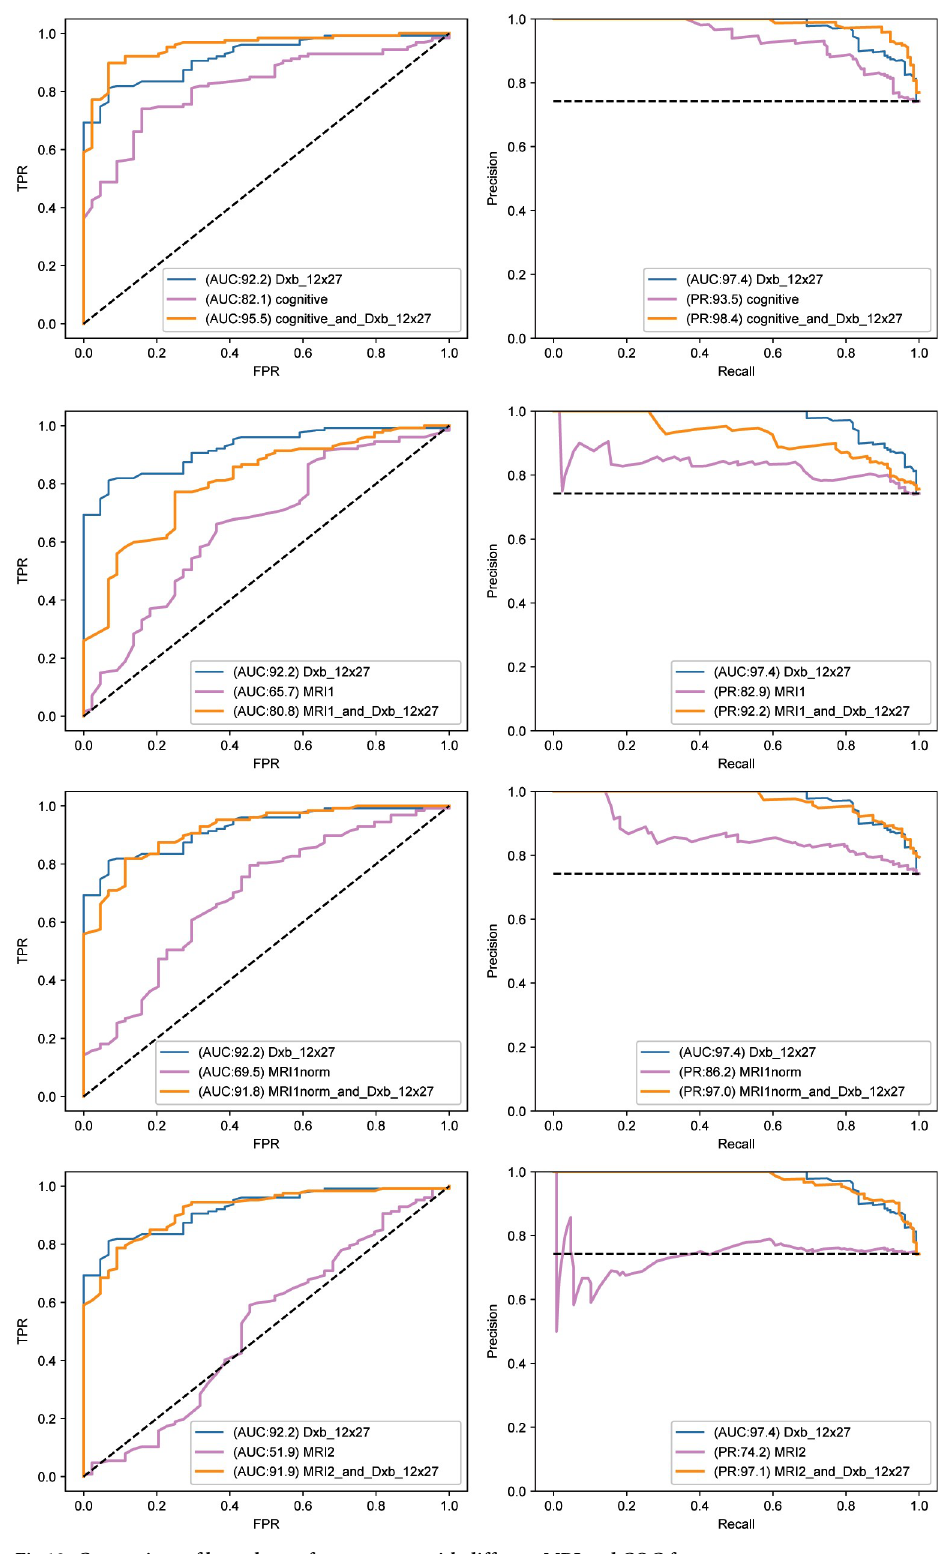
Fig 10. Comparison of best plasma feature group with different MRI and COG feature groups as comparators. The compactor feature groups are cognitive, MRI1, MRInorm, and MRI2 (from top to bottom). They are all compared to the best plasma feature group. Fig 10 has the same format as Fig